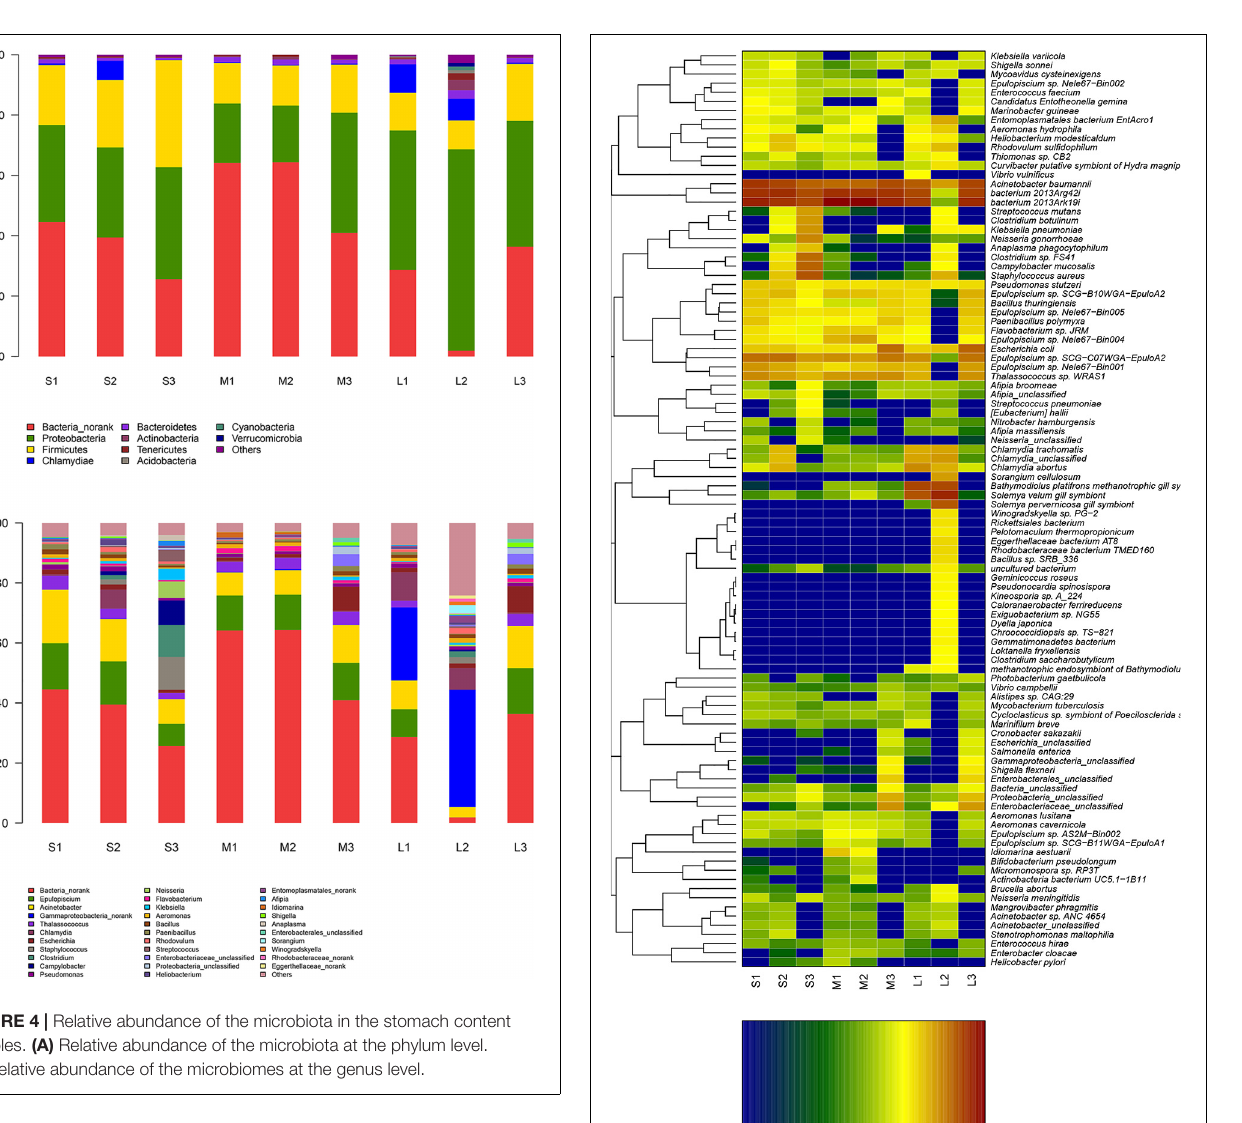
sequencing and the increasing data output make it difficult for (Wu et al.,